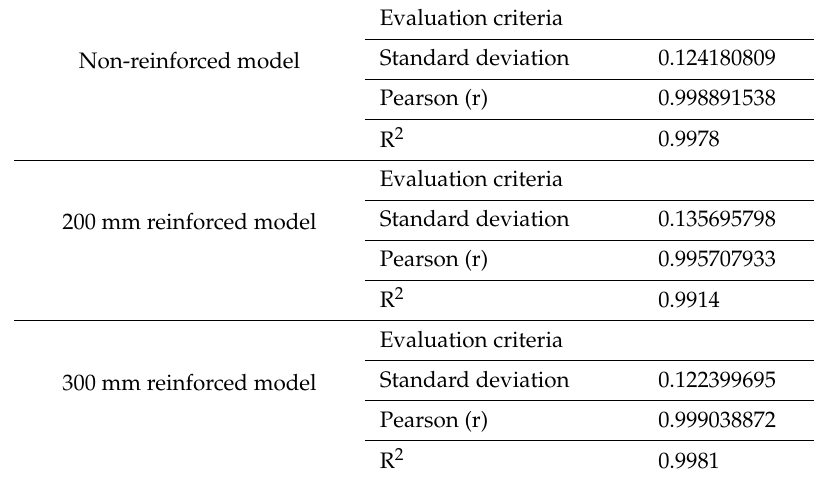
Figure 29. Comparison of finite element model against major axis test results along with the linear regression: ( A ) and ( B ) non-reinforced model; ( C ) and ( D ) 200 mm reinforced model; ( E ) and ( F ) 300 mm reinforced model. Table 6. Finite element model vs experimental results accuracy details in terms of evaluation criteria.